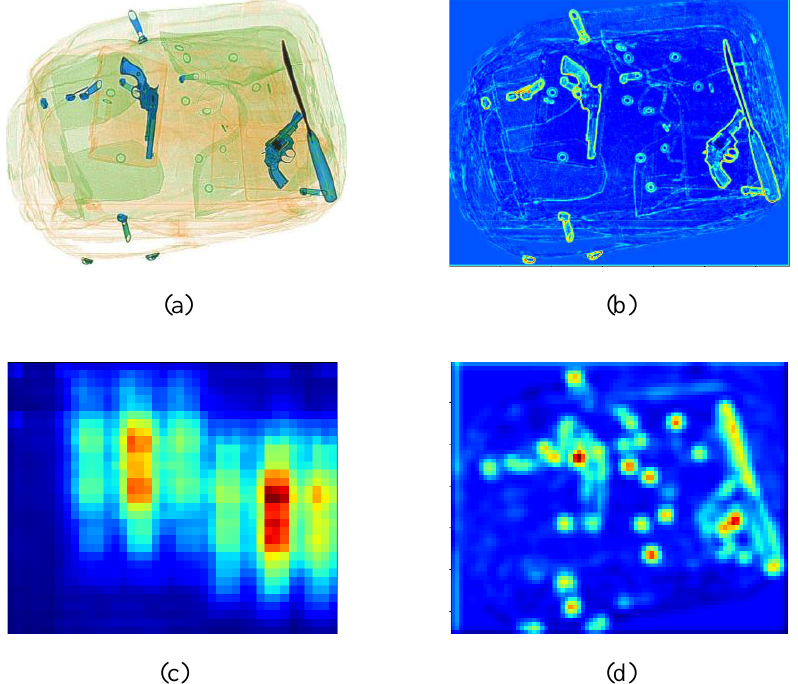
Figure 6. Original X-ray image and feature outputs from different convolutional layers from the backbone of RFB Net. ( a ) is the original image, ( b ) is the 2nd layer output, ( c ) is the 15th layer output and ( d ) is the 9th layer